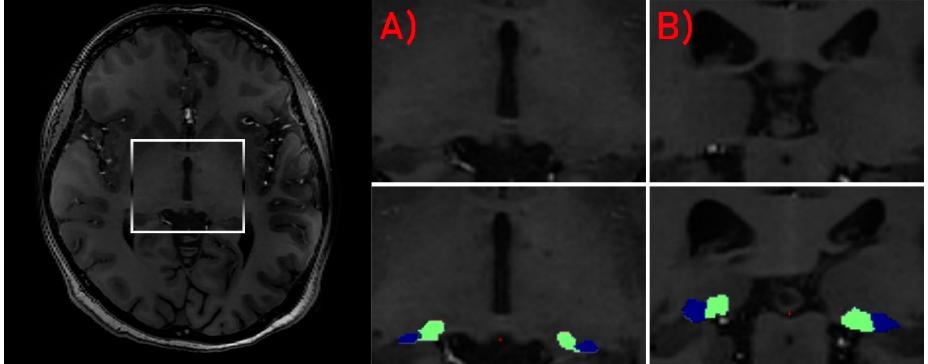
Figure 2. Segmentation of LGN (blue) and MGN (green). Axial ( A ) and coronal ( B ) views of the nuclei.